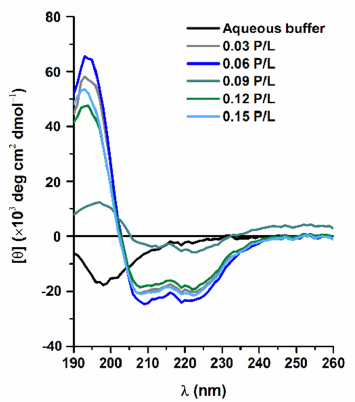
Figure 1. Far-UV CD spectra of W-BP100 in aqueous buffer and in the presence of anionic LUVs. Representative spectra of molar ellipticity per residue of W-BP100 in POPC:POPG (1:1) LUVs at increasing P/L ratios. Data were obtained at 20.00 ± 0.01 °C and each spectrum was acquired in 10 mmol dm − 3 sodium phosphate buffer, pH 7.4, with an average of 16 accumulations for each spectrum